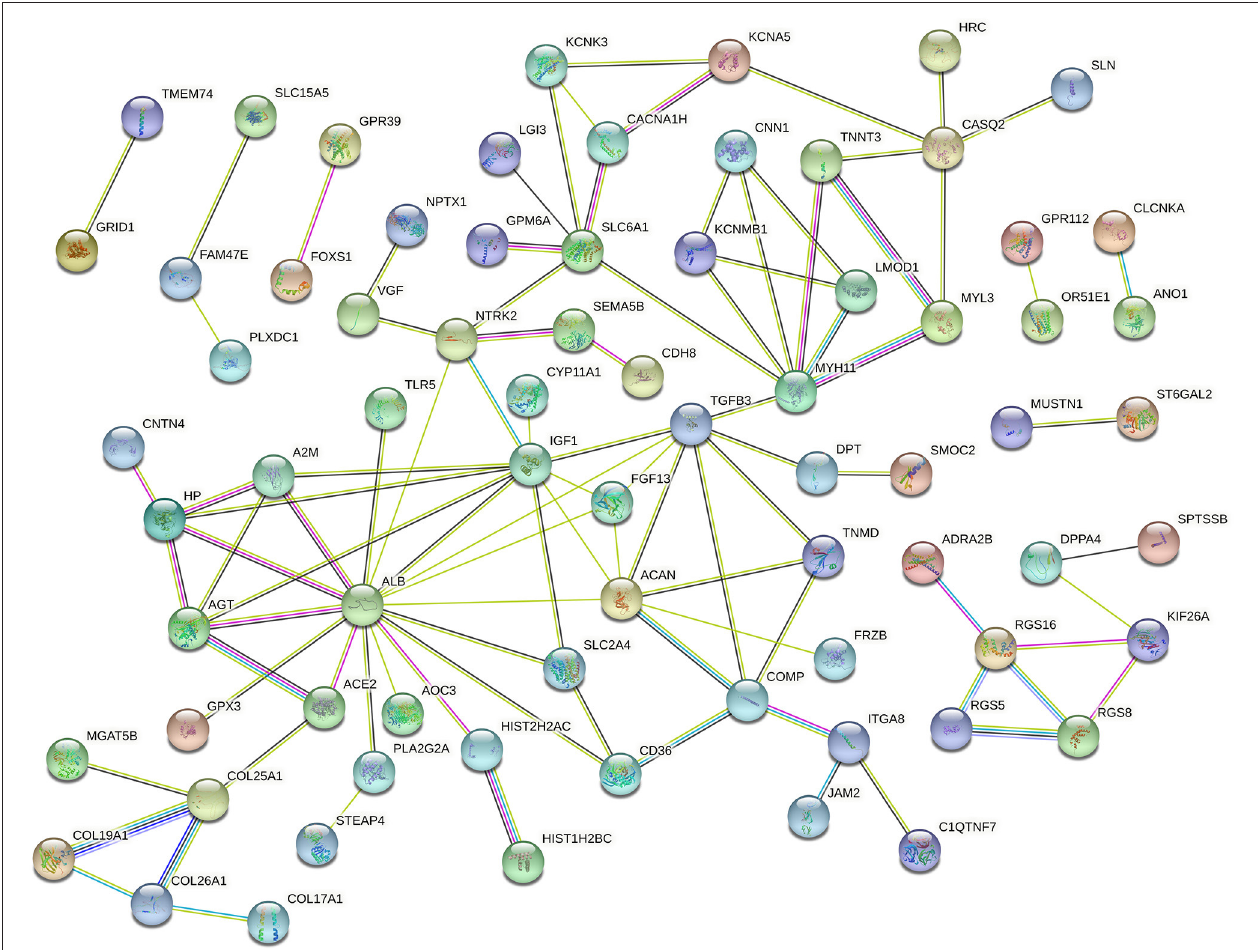
FIGURE 4 | Protein–protein interaction network of DEGs in Ang II vs.